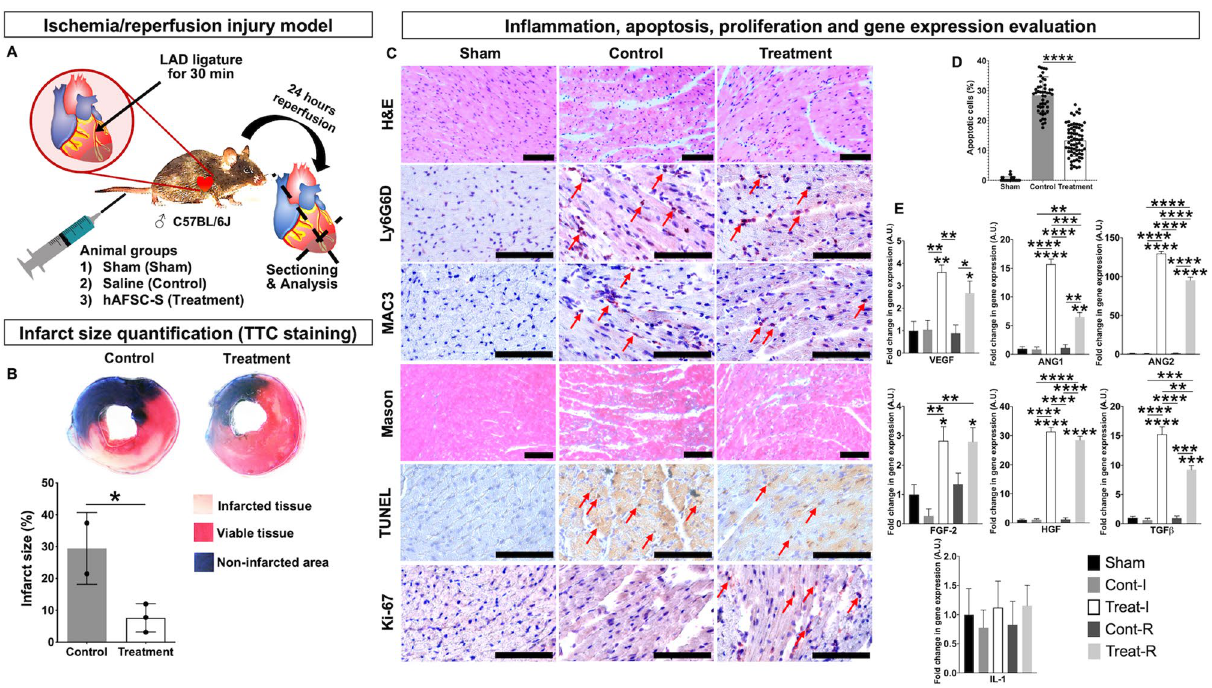
Figure 6. Human hypoxic amniotic fluid stem cells secretome (hAFSC-S) reduces myocardial tissue injury in an ischemia/reperfusion (IR) injury mouse model. ( A ) Male C57BL/6 J mice were treated with 1) saline (Control, n = 4), 2) 20x concentrated 30h-hAFSC-S (Treatment, n = 6) injected via tail vein 5 min before removing the vascular occlusion. One mouse was used as a sham. Animals were sacrificed after 24 h of reperfusion. ( B ) The mouse heart (saline n = 2, treatment n = 3) was cross-sectioned into 5 pieces and stained in 1%TTC (triphenyl tetrazolium chloride). The non-infarcted area was stained in blue (Evan’s blue; Non- infarcted area). Within the area at risk, infarcted tissue was stained in pale pink (Infarcted tissue) and viable tissue in red (Viable tissue). Infarct size was calculated as the percentage of Infarcted tissue of ischemia-affected tissue. Data are expressed as means ± SD. * p < 0.05 by unpaired t-test. ( C ) Longitudinal heart sections (sham n = 1, saline n = 2, treatment n = 3) were stained for 1) tissue composition (hematoxylin–eosin, H&E), 2) neutrophils (Lymphocyte antigen 6 complex locus G6D, Ly6G6D), 3) macrophages (macrophage differentiation antigen, MAC3), 4) collagen deposition (Masson Trichome), 5) cell apoptosis (Terminal deoxynucleotidyl transferase dUTP nick end labeling, TUNEL) and 6) cells in active phases of cell-cycle (Ki-67). Red arrows indicate positively stained cells. Scale bar 100 μm. ( D ) Apoptotic cells quantification expressed as percentage of TUNEL positive cells over total amount of cells. Data are expressed as means ± SD, **** p < 0.0001 by one-way ANOVA. E) Quantitative real-time polymerase chain reaction (qRT-PCR) analysis of pro-angiogenic (VEGF, ANG1, ANG2, FGF-2, HGF), anti- (TGF-β) and pro-inflammatory (IL-1) genes in ischemic (I) and remote (R) areas of heart tissue in sham (Sham), saline control (Cont-I, Cont-R) and 30h-hAFSC-S treatment (Treat-I, Treat-R). Beta-actin (β-Actin) was used as the normalization control and sham control sample were used as the calibrator. The relative quantification was performed using the comparative CT (2−ΔΔCT) method. * above the bar indicates statistical significance between sham and saline (Cont-I, Cont-R) or treatment groups (Treat-I, Treat-R). * indicates statistical significance between saline (Cont-I, Cont-R) and treatment (Treat-I, Treat-R). Data are expressed as means ± SD. * p < 0.05, ** p < 0.01, *** p < 0.001, **** p < 0.0001 by two-way ANOVA followed by Tukey’s post hoc